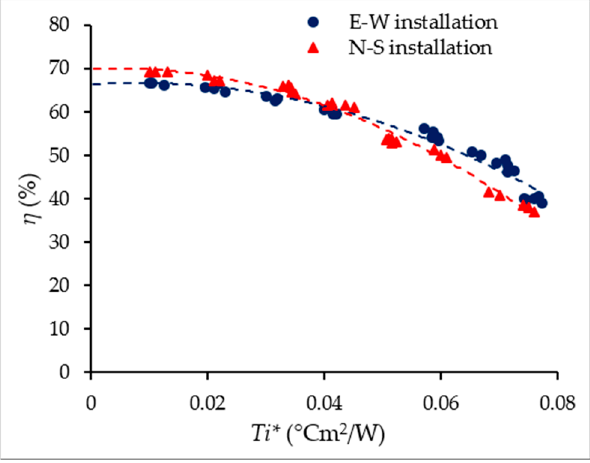
Figure 16. Experimental efficiency of CPC paired with CT receiver installed in E-W and N-S directions.